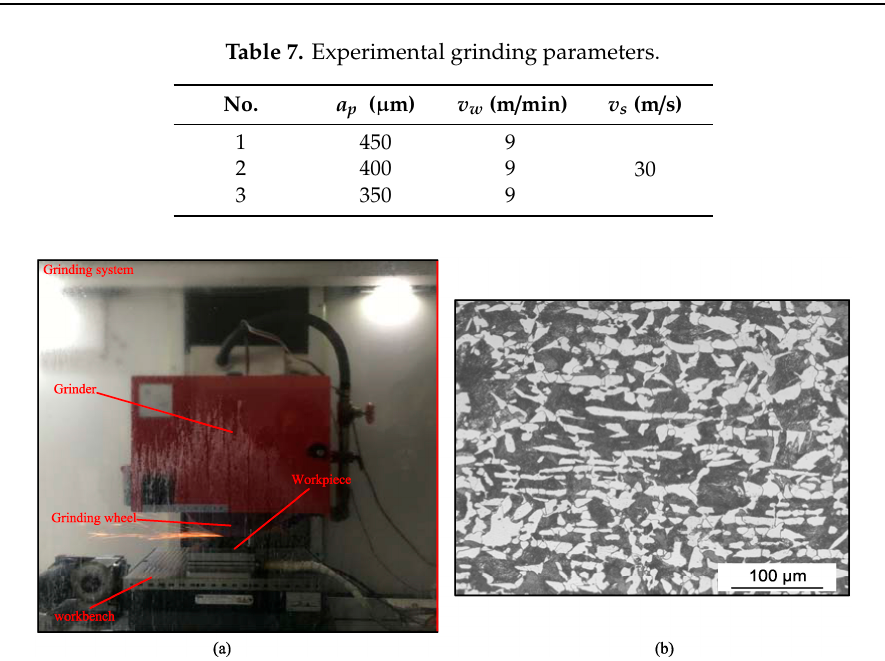
Figure 3. ( a ) Experimental setup; ( b ) initial microstructure of AISI 1045